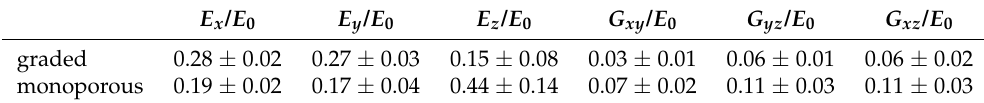
Table 1. Dimensionless macroscopic Young’s moduli and shear moduli for both classes of scaffolds. E x / E 0 E y / E 0 E z / E 0